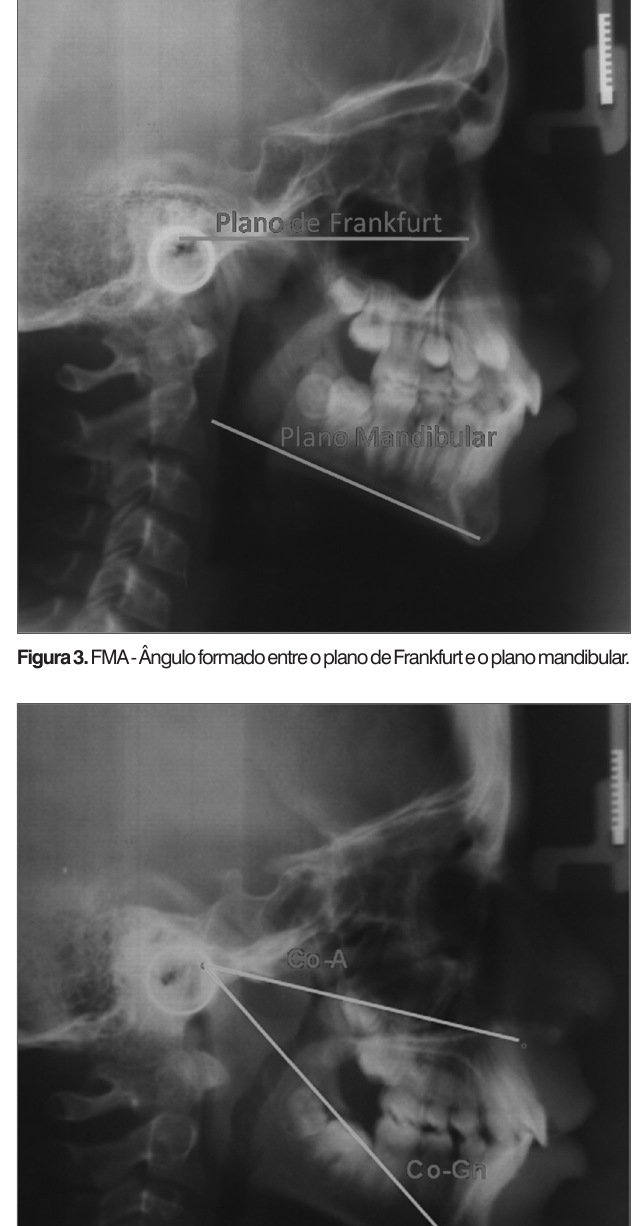
Figura 2. SN.GoMe - Ângulo formado entre a base craniana anterior (SN) e o plano mandibular (GoMe).